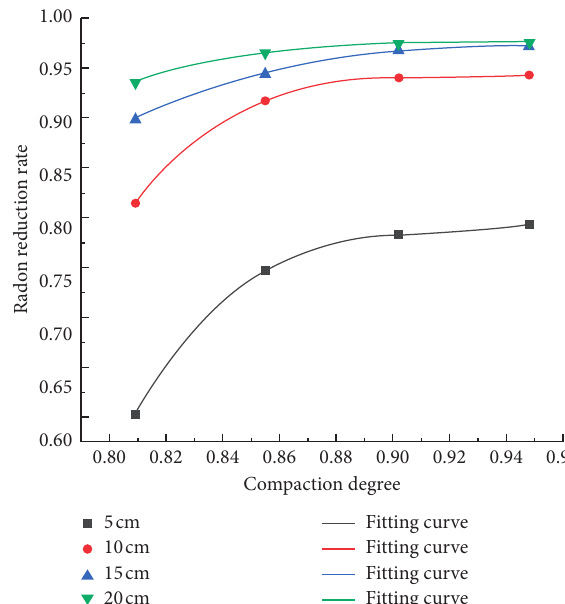
Figure 5: Relation curve between the radon reduction rate and compaction degree.